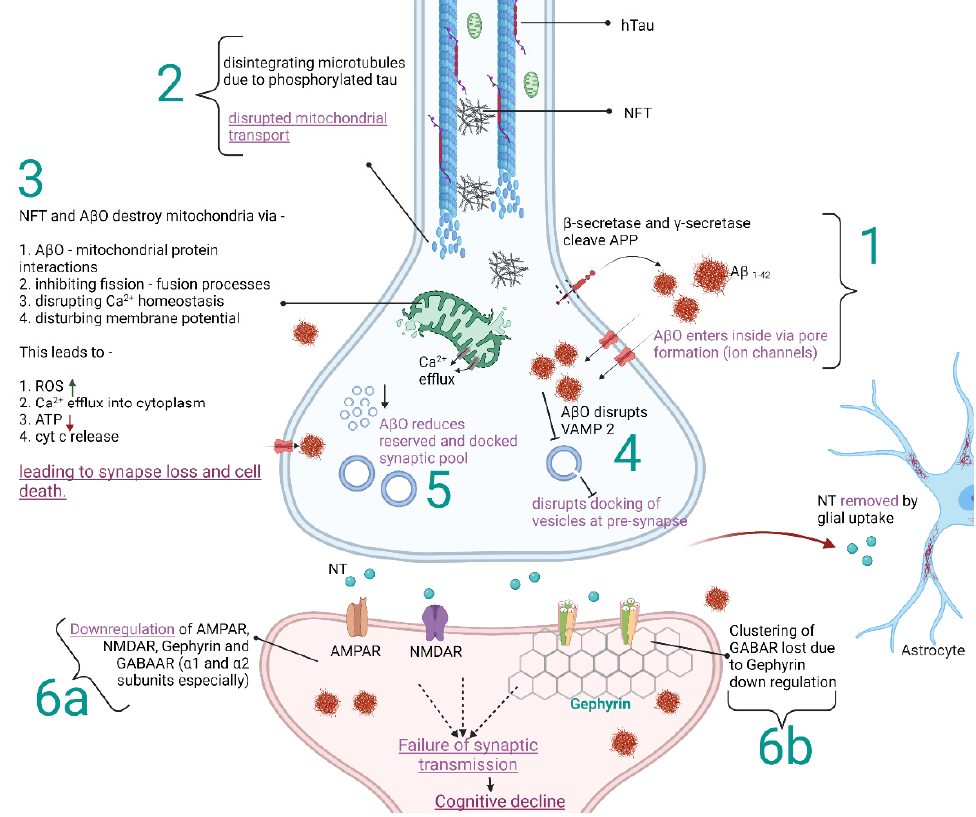
Figure 1. Schematic representation of the direct and indirect influence of amyloid-beta oligomers (A β O), hyperphosphorylated tau (hTau), and neurofibrillary tangles (NFT) on synaptic components in the context of Alzheimer’s disease (AD). The figure represents an example of the influence of protein aggregates and biomarkers on synaptic plasticity at functional and molecular levels in neurodegenerative diseases, which affects the cognitive functions of the brain. α -amino-3-hydroxy-5- methyl-4-isoxazole propionic acid receptor (AMPAR) and N-methyl D-aspartate Receptors (NMDAR) are glutamate receptors present on the postsynaptic membrane. GABAAR— γ -aminobutyric acid type-B receptors; APP—amyloid-beta precursor protein; Ca 2+ —calcium ion; ROS—reactive oxygen species; ATP—adenosine triphosphate; cyt c—cytochrome c; VAMP 2—Vesicle-associated membrane protein 2; NT—neurotransmitter [3,10–21].